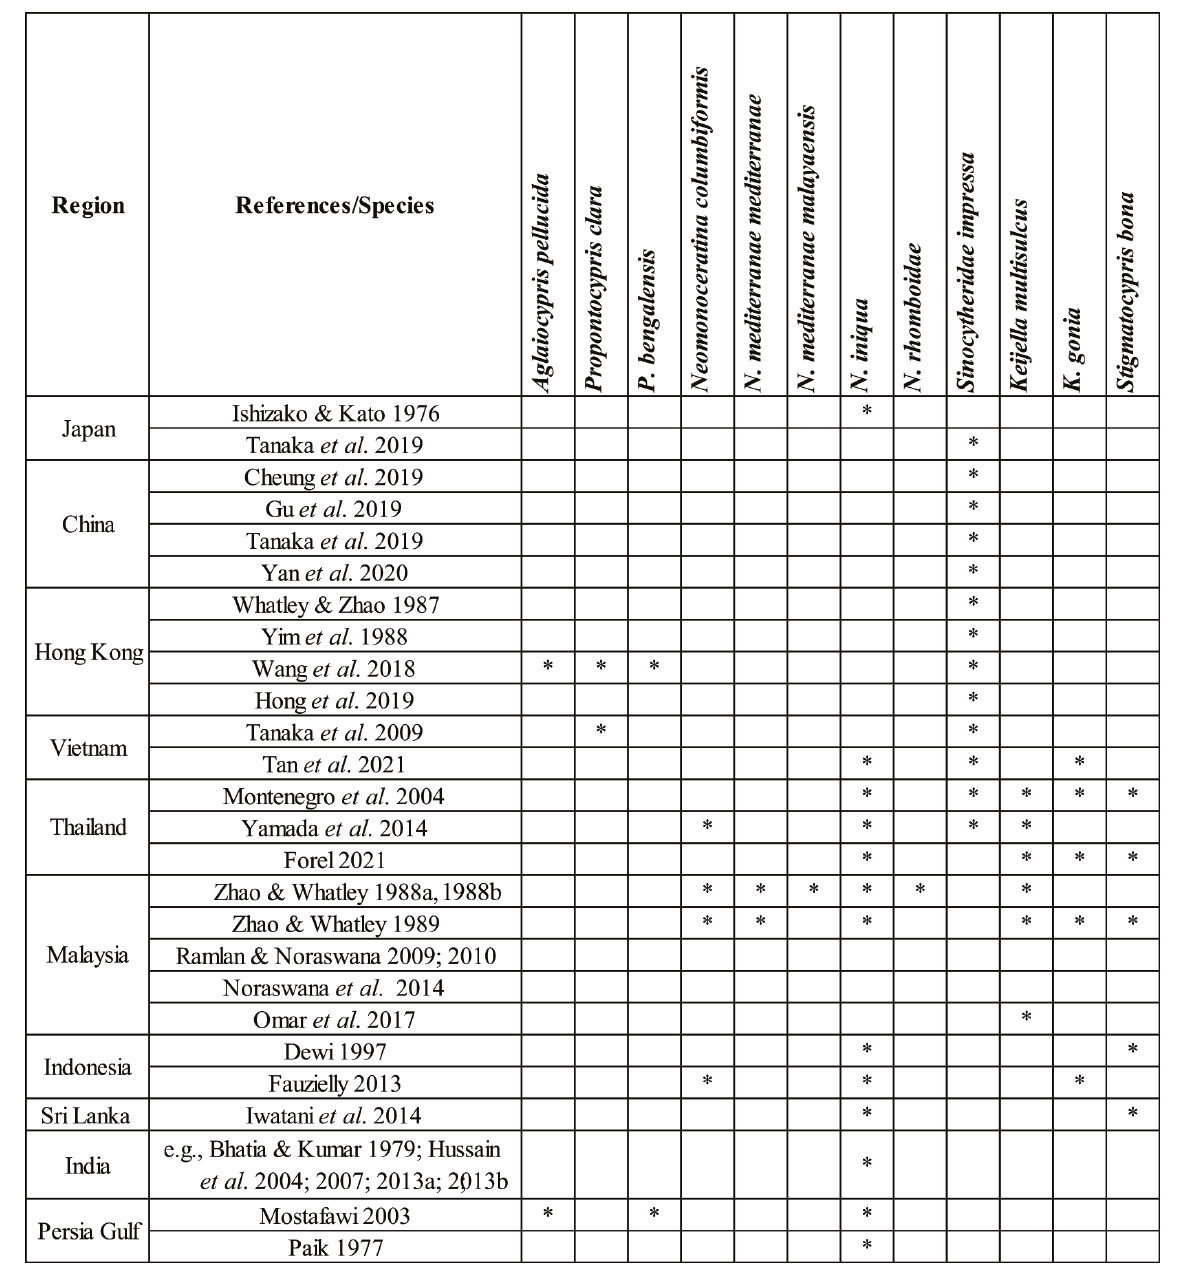
Table 1. Geographical distributions of Holocene ostracods from the marine Bangkok Clay in Samut Sakhon Province, north of the Gulf of